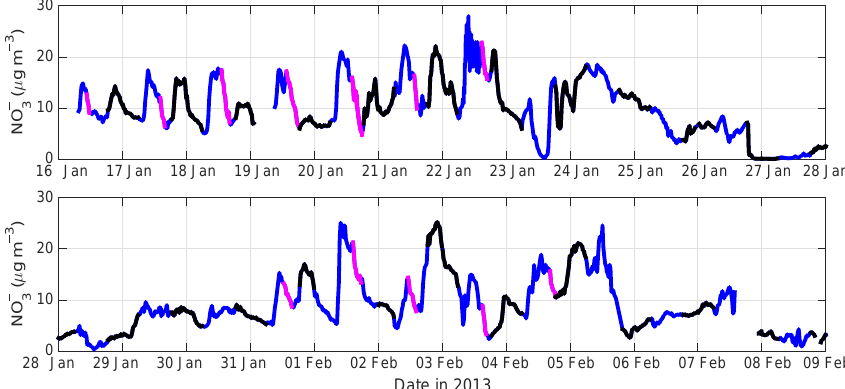
Figure 7. Time series of NO − (µgm − 3 ) in PM 1 measured at the ground in Fresno during DISCOVER-AQ. Days are in blue and nights are 3 in black. Select afternoon data (magenta) were fit to derive τ NO − 3